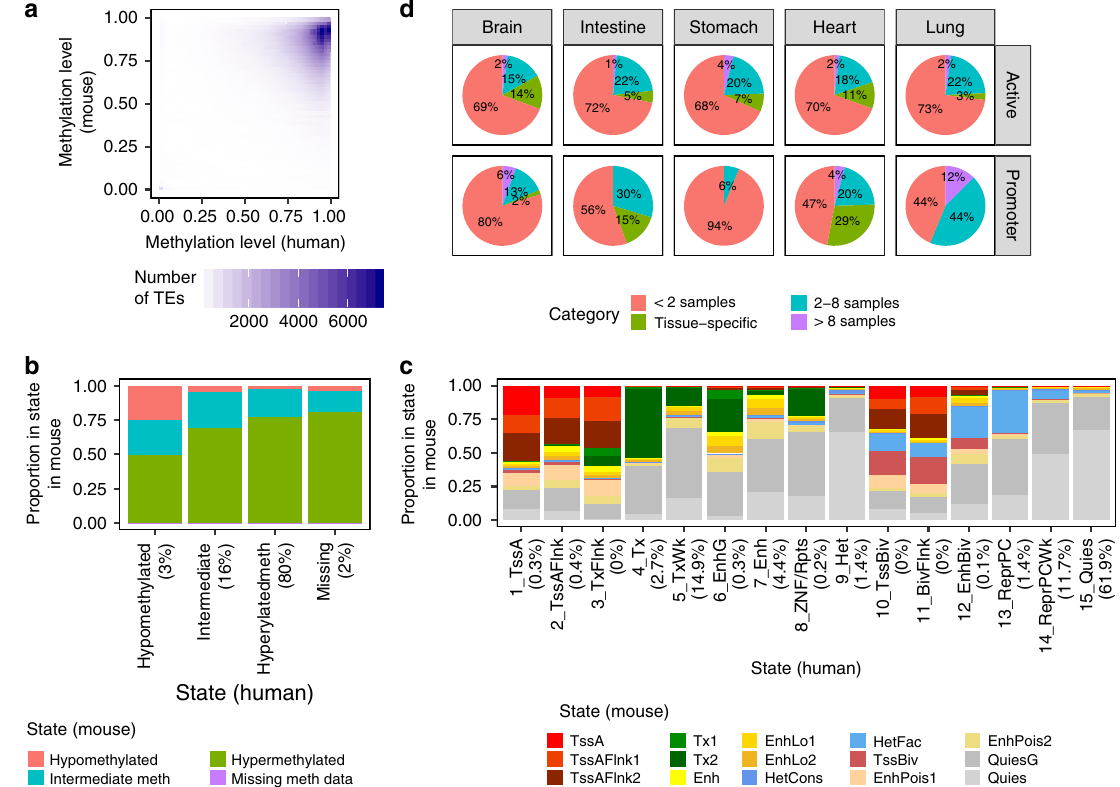
Fig. 7 Conserved epigenetic pro fi les of orthologous TEs in human and mouse. a 2D density plot of the methylation level of orthologous TEs ( n = 140,185 TEs) in seven anatomy-matched human-mouse epigenome pairs. TE pairs missing methylation in either epigenome or lacking CpGs are excluded. b Methylation state of orthologous TEs in human and mouse across the seven epigenome pairs. Percentages to the right of each x -axis state indicate the proportion of TE ortholog instances across the epigenome pairs that are annotated with that state. c chromHMM state of orthologous TEs ( n = 296,457 TEs) in human and mouse across twelve anatomy-matched epigenome pairs. Percentages to the right of each x -axis state indicate the proportion of TE ortholog instances across the epigenome pairs that are annotated with that state. d Tissue-speci fi city pro fi les in mouse for orthologous TEs that exhibit tissue speci fi city in that tissue in human. TEs are considered tissue-speci fi c if they are annotated with a state in two epigenomes from the same tissue but fewer than 5 epigenomes overall. Active: any active regulatory state (Brain n = 1,812 TEs, Intestine n = 1,691, Stomach n = 205, Heart n = 3,081, Lung n = 653); Promoter: 1_TssA/TssA (Brain n = 54 TEs, Intestine n = 27, Stomach n = 16, Heart n = 49, Lung n = 16). TEs in the 2 – 8 epigenomes category are not speci fi c to the